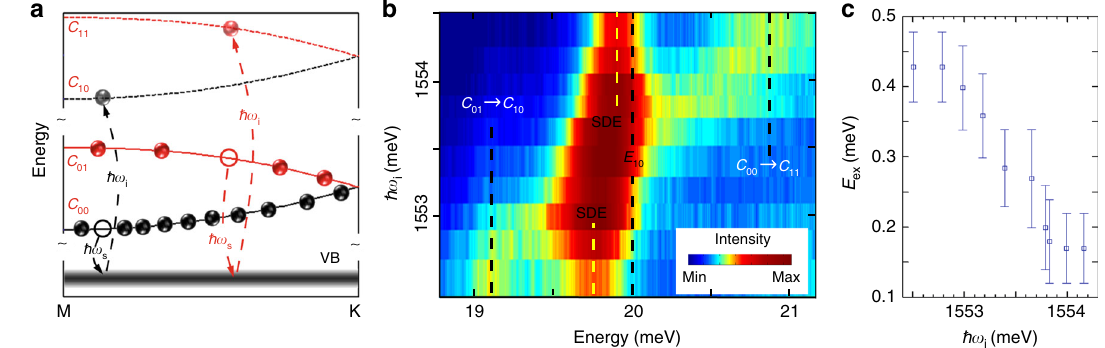
Fig. 4 Coulomb exchange energy probed in intersubband excitations. a Optical transitions in RILS of intersubband spin-density excitations (SDE) are indicated. In transitions with incident photon energy ħ ω i , the incident photon excites an electron from the valence band (VB) to the c 11 / c 10 state leaving behind a hole. In transitions with scattered photon energy ħ ω s , an electron in the c 01 / c 00 state recombines with the hole and emits the scattered photon. The incident photon energy ħ ω i and scattered photon energies ħ ω s are linked by energy conservation E = ħ ω i − ħ ω s , where E is the energy of AG excitations being studied. In SDE, the electrons are excited from a lower populated AG subband to the next higher subband without the change in AG band index. Red (black) line de fi nes SDE exciting electron states with spin- fl ip processing from c 01 and c 11 (from c 00 and c 10 ) under higher (lower) ħ ω i . While the c 01 band is above the Fermi energy it is populated because of the thermal excitation of charge carriers at fi nite temperature of our experiments. b Color plot of RILS spectra as a function of ħ ω i measured at temperature T = 5 K with crossed polarization. The color bar indicates intensities of scattered light. The dashed lines marked with c 01 → c 10 and c 00 → c 11 indicate the energies of combined intersubband transitions with the change in both quantum well subband and AG band index (see ref. 25 and Supplementary Note 2). The dashed line marked with E 10 indicates the position of quantum well subband spacing (see Supplementary Note 2). The yellow dashed lines indicate the position of SDE. There is a weak photoluminescence that overlaps the c 01 → c 10 and c 00 → c 11 transitions, as well as SDE. c The dependence of exchange energies extracted from ( b ) on ħ ω i . The vertical error bars represent estimated uncertainties